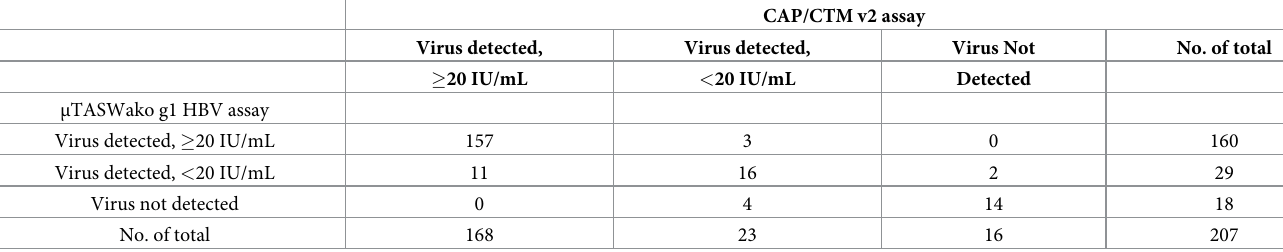
Table 4. Qualitative results of μ TASWako g1 HBV assay and CAP/CTM v2